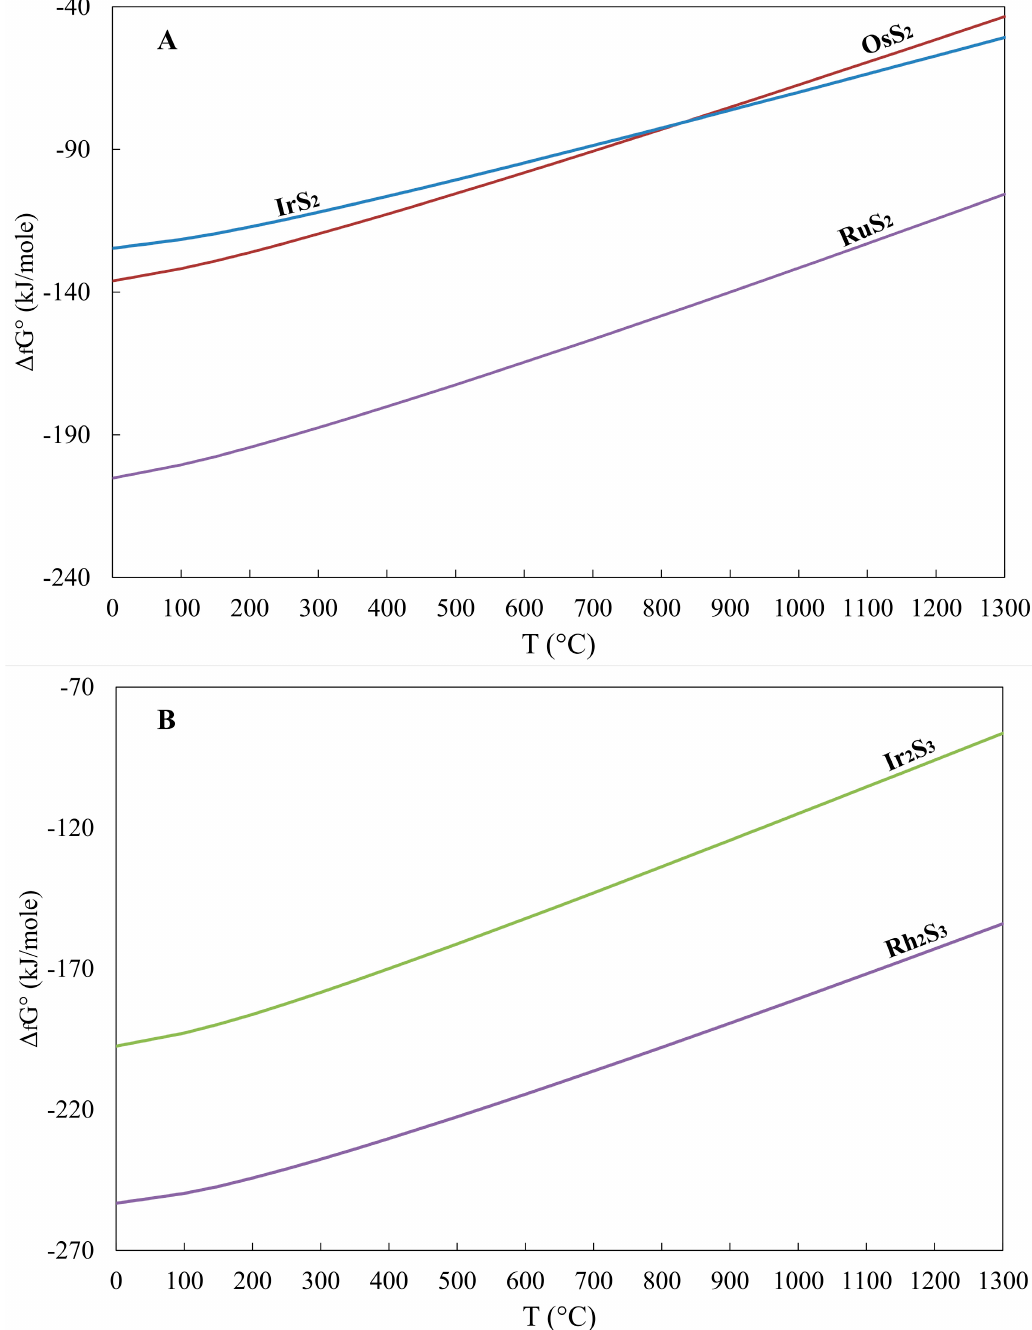
Figure 2. Plot of the Free energy ( Δ f G°) against temperature for ( A ) RuS 2 (laurite), OsS 2 (erlichmanite) and IrS 2 (unnamed iridium disulfide) and ( B ) Rh 2 S 3 (bowieite) and Ir 2 S 3 (kashinite). Data from Table 4. With respect to the recorded difference between the diagrams showing smooth curves (Figure 2A, Band 3B) and diagram for tellurides (PtTe 2 , PdTe 2 and IrTe 2 (Figure 3A)), showing an abrupt change of direction at 450 ˝ C (Figure 3B), it may be related to the phase changes, as is exemplified by a phase change at 449.51 ˝ C, for compositions between PtTe 2 and Te (melting point of Te metal) in the related phase diagram